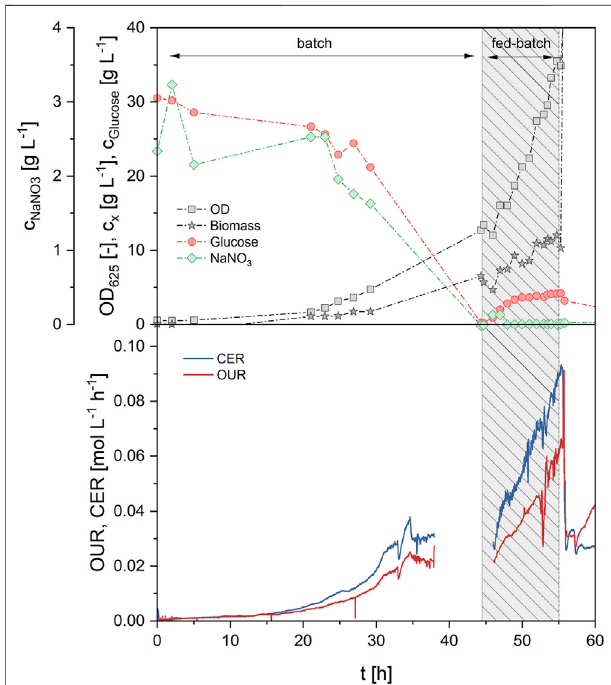
FIGURE 6 | Process data of fed-batch process 1 (FB1) during growth phase (0 – 55 h) showing concentrations of glucose, NaNO 3 , biomass and OD (upper) and off-gas analysis (lower graph). Medium feeding was applied from 44.5 – 55 h with an exponential feed rate at µ set = 0.08 h − 1 , leading to a further increase of biomass, OUR and